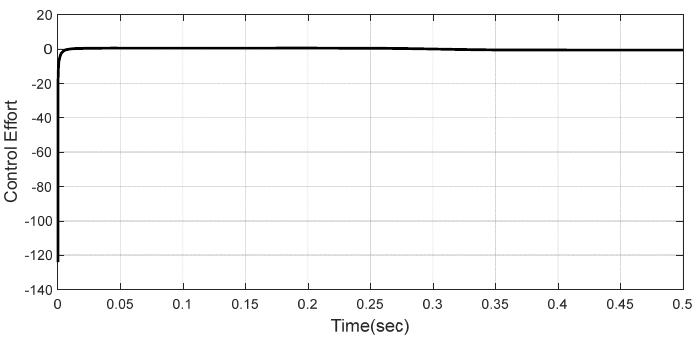
Figure 32. The behaviour of the inductor current and output voltage in case of output voltage changes and in the presence of measurement noise.